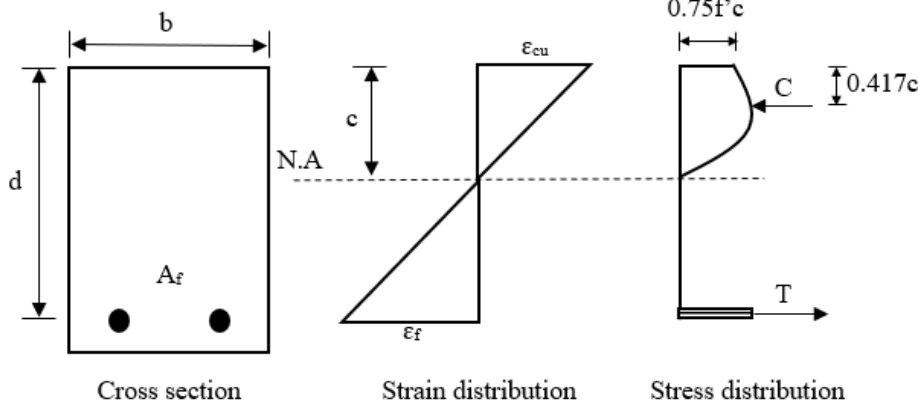
Figure 11. Stress–strain distribution in parabolic stress block based on [34] .